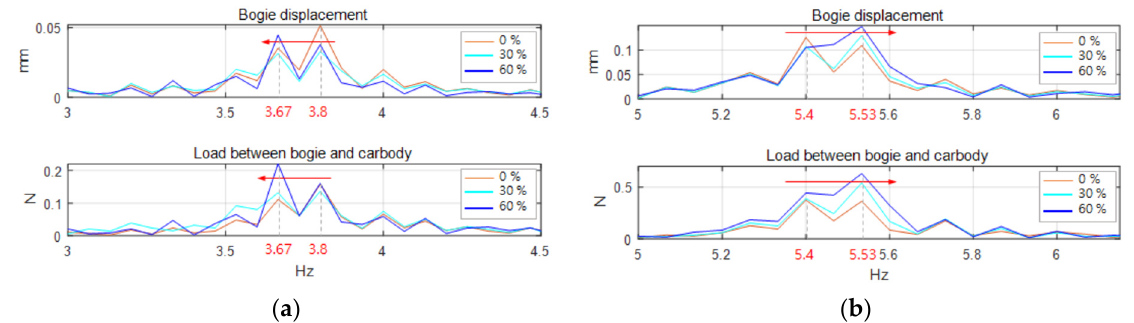
Figure 11. Effect of load cell value on vibration frequency: ( a ) vertical direction, ( b ) lateral direction.